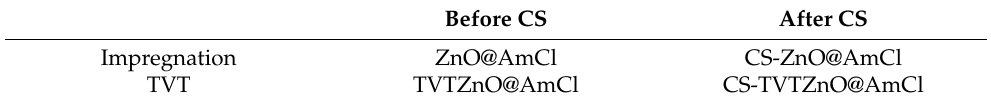
Table 1. The sample’s reference designations.